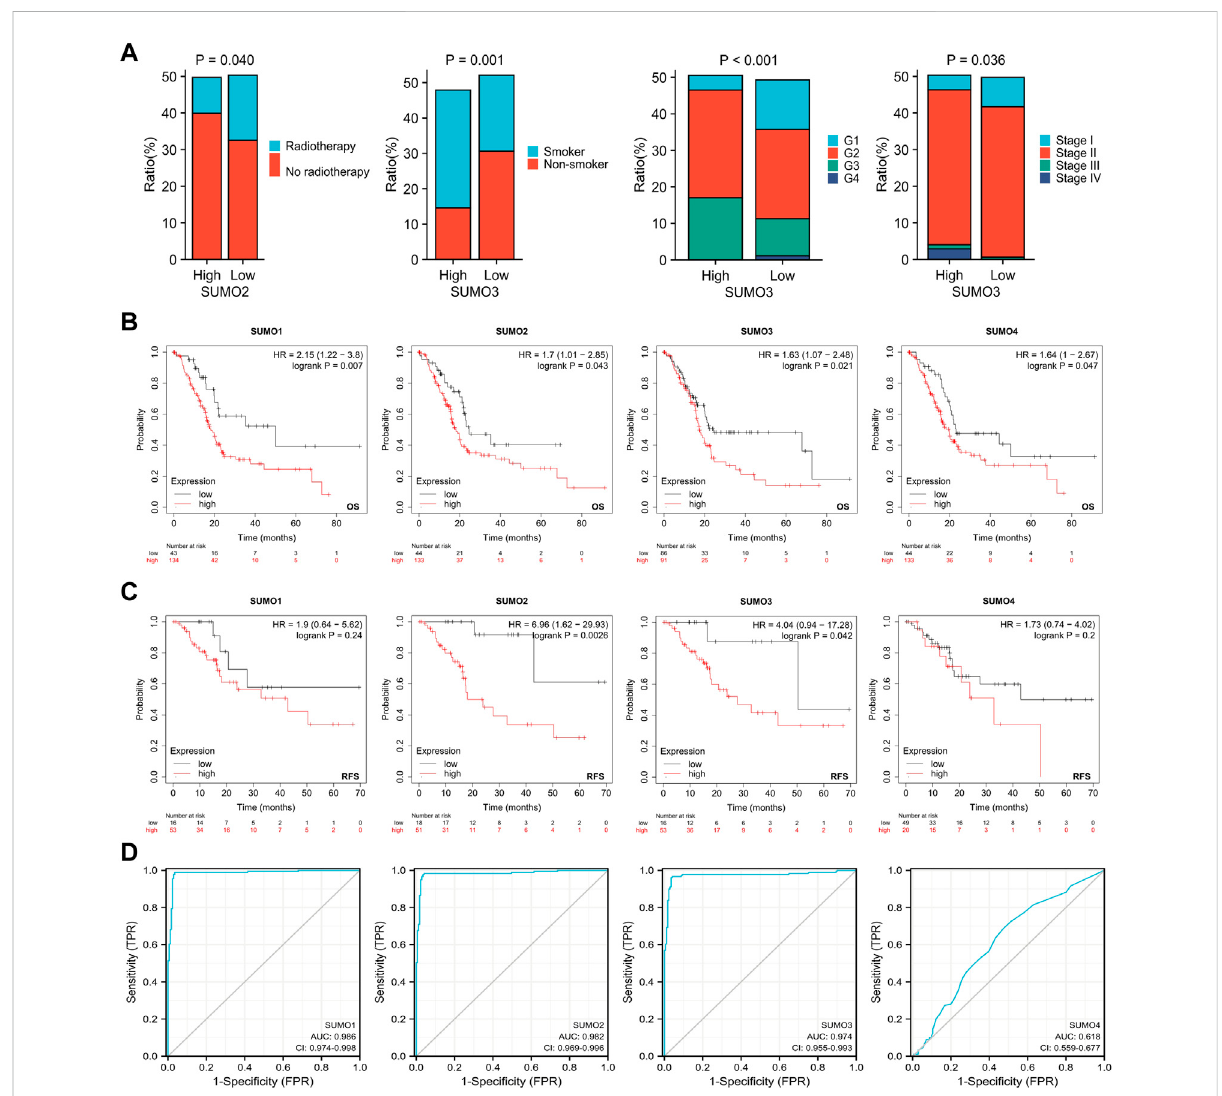
FIGURE 2 Relationship between expression levels of SUMO family members and clinicopathological features and prognosis of patients with PAAD. (A) Higher proportion ofPAAD patients withhigh SUMO2expression whodidnot receiveradiotherapy;PAAD patients withhigh SUMO3 expressionhad ahigherproportionofpatientswithsmokinghistory,highertumorgradeandhighertumorstage; (B) TheincreasedexpressionlevelsofSUMOfamily members were signi fi cantly correlated with shorter OS; (C) The increased expression levels of SUMO 2/3 were signi fi cantly correlated with shorter RFS; (D) SUMO family members showed high accuracy in predicting normal and neoplastic